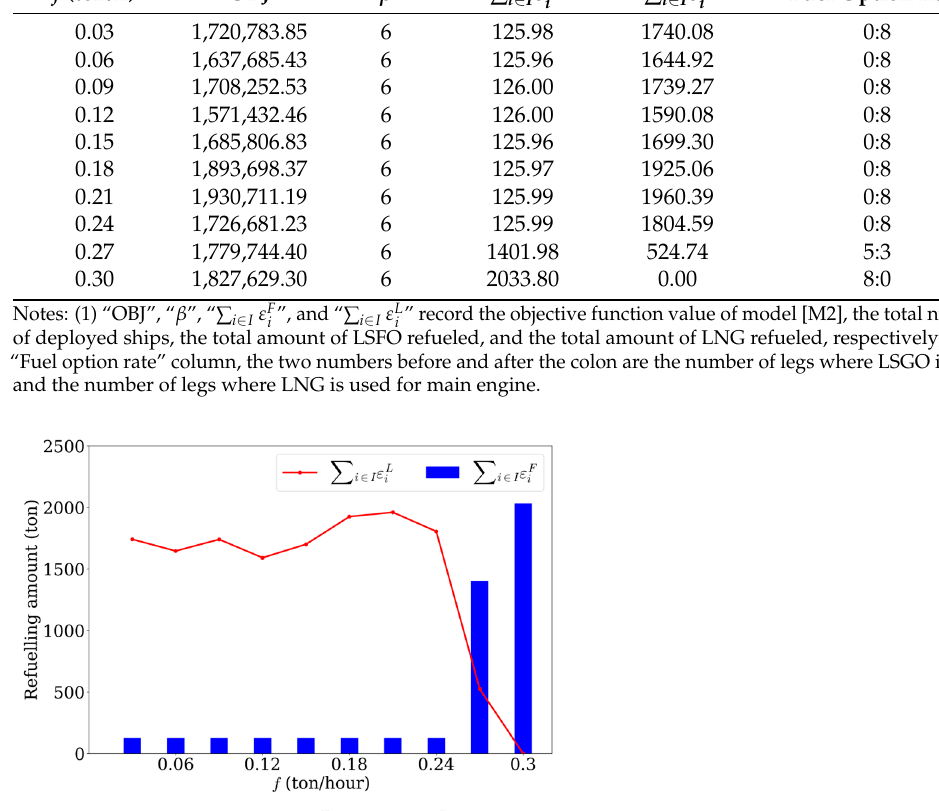
Figure 3. Comparison of ∑ i ∈ I ε F